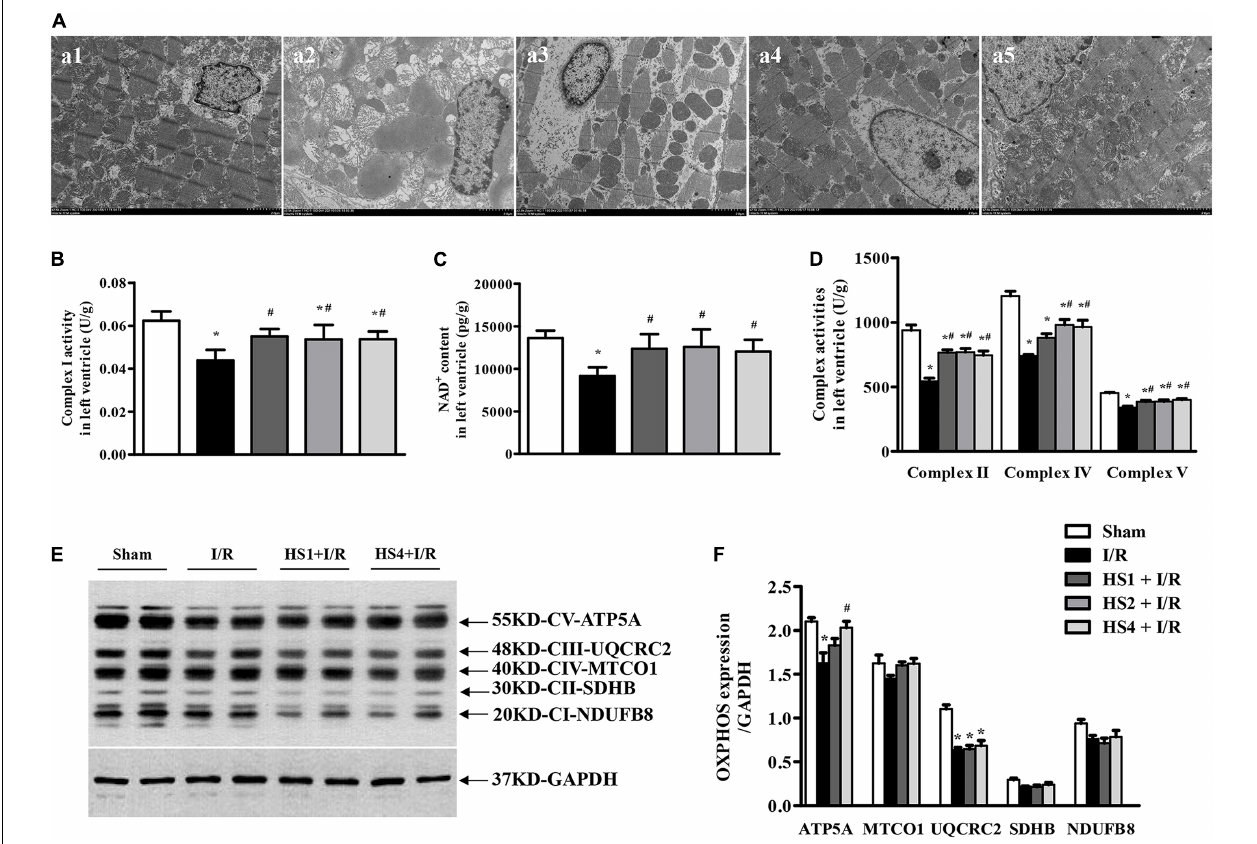
FIGURE 7 | Effect of Herba Siegesbeckiae (HS) on myocardial ultrastructure and mitochondrial ETC function. (A) Representative images of myocardial ultrastructure acquired at × 2.5 K magnification in Sham (a1), I/R (a2), HS1 + I/R (a3), HS2 + I/R (a4), and HS4 + I/R (a5) groups. (B,C) The Complex I activity (B) and NAD + content (C) in left ventricle in various groups ( n = 6). (D) The activities of Complexes II, IV, and V in the left ventricle in various groups ( n = 6). (E) The representative image of OXPHOS expression. (F) The quantitative analysis of OXPHOS expression ( n = 4). * P < 0.05 vs. Sham group, # P < 0.05 vs. I/R